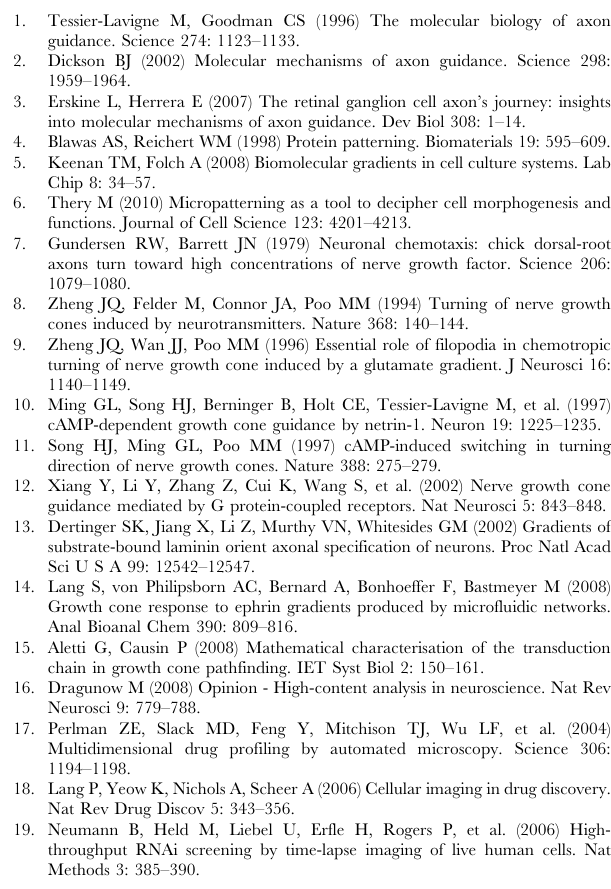
Figure S1 Histograms of the initiation angle of cells imaged on low-slope and high-slope gradients at different time points before and during differentiation by staurosporine. Attracted (black, + ) and repulsed (white, 2 ) neurites were determined as described in Figure 2a. (TIF) Figure S2 Histograms of the terminal angle of cells imaged on low-slope and high-slope gradients at different time points before and during differentiation by staurosporine. Attracted (black, + ) and repulsed (white, 2 ) neurites were determined as described in Figure 2a. (TIF)